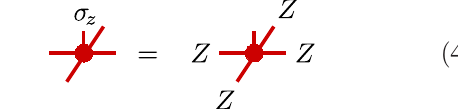
be extracted from the tensor (and is needed only in case we want to carry out the mapping explicitly).